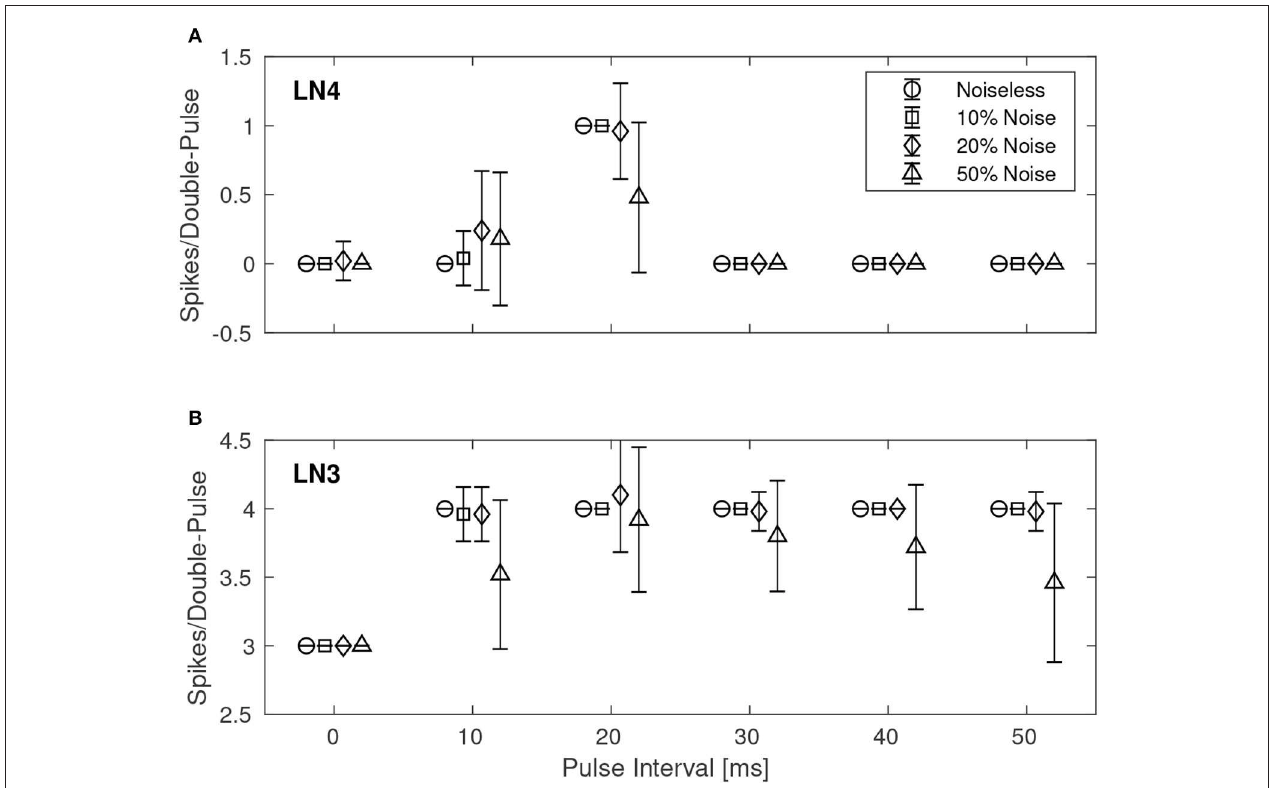
FIGURE 8 | Average number of spikes from LN3 and LN4 per double-pulse stimulus for varying IPIs and different levels of spike-timing noise in the stimuli. For each IPI, the data-points are graphically separated by 4/3 ms to improve the clarity of the visualization. Error bars denote ± 1 standard deviation. (A) Feature detecting neuron, LN4. (B) Coincidence detecting neuron,